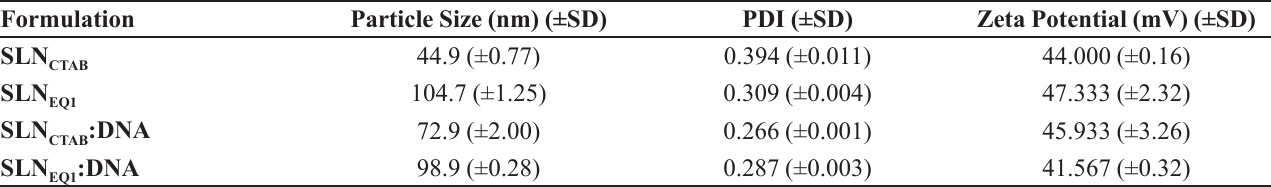
: SLN formulation prepared with CTAB as the cationic lipid, SLN CTAB